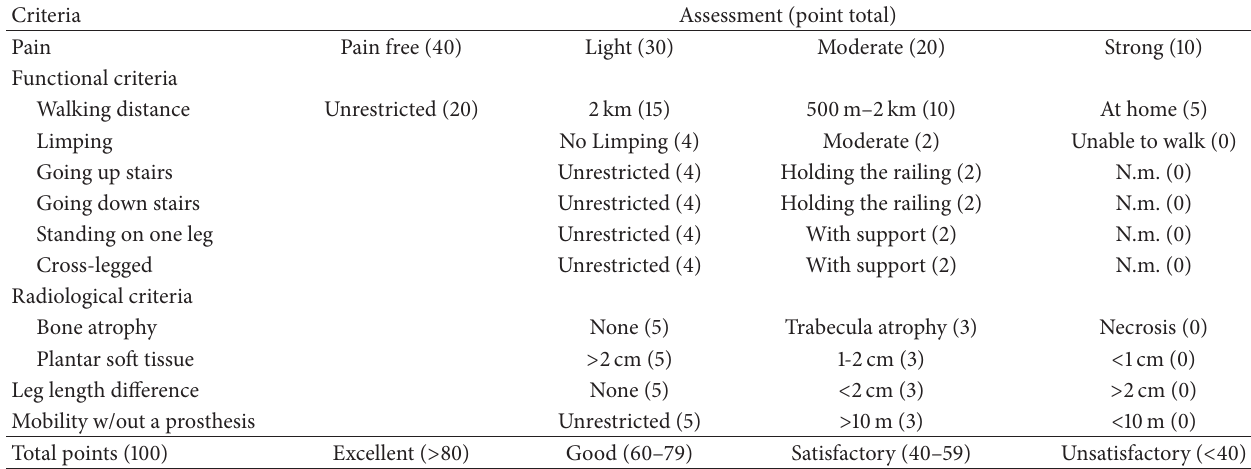
Table 2: Modified Ankle and Hindfoot Score (AOFAS) with consideration given to the lack of ankle function and more weight given to functional and radiological criteria based on Taniguchi (Ankle Score)